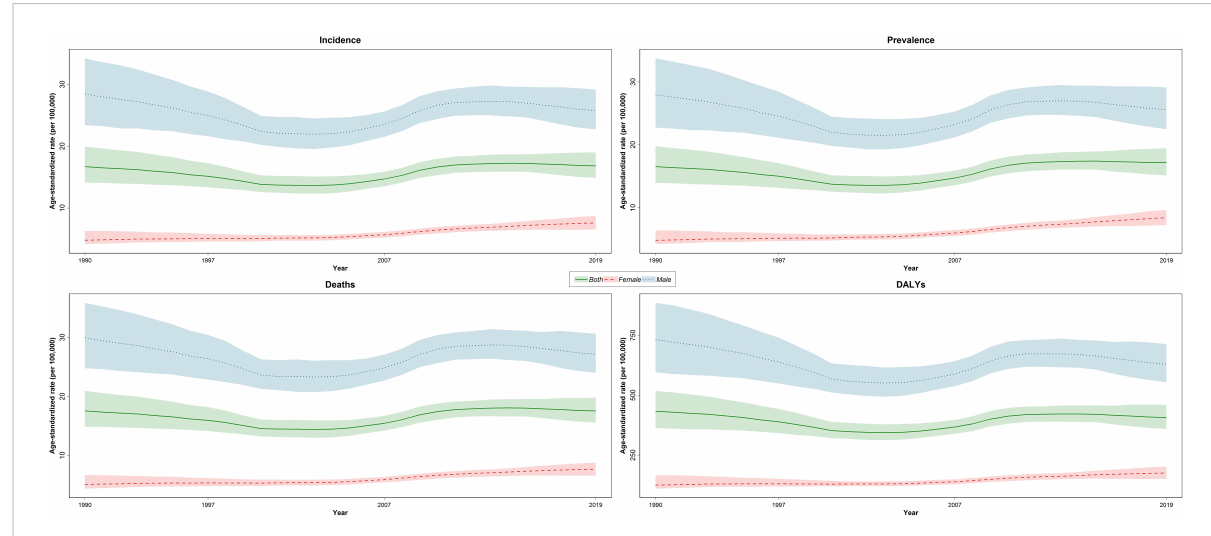
FIGURE 1 Time trend of age-standardized rate of incidence, prevalence, deaths, and DALYs by sex in region DALYs = disability-adjusted life years